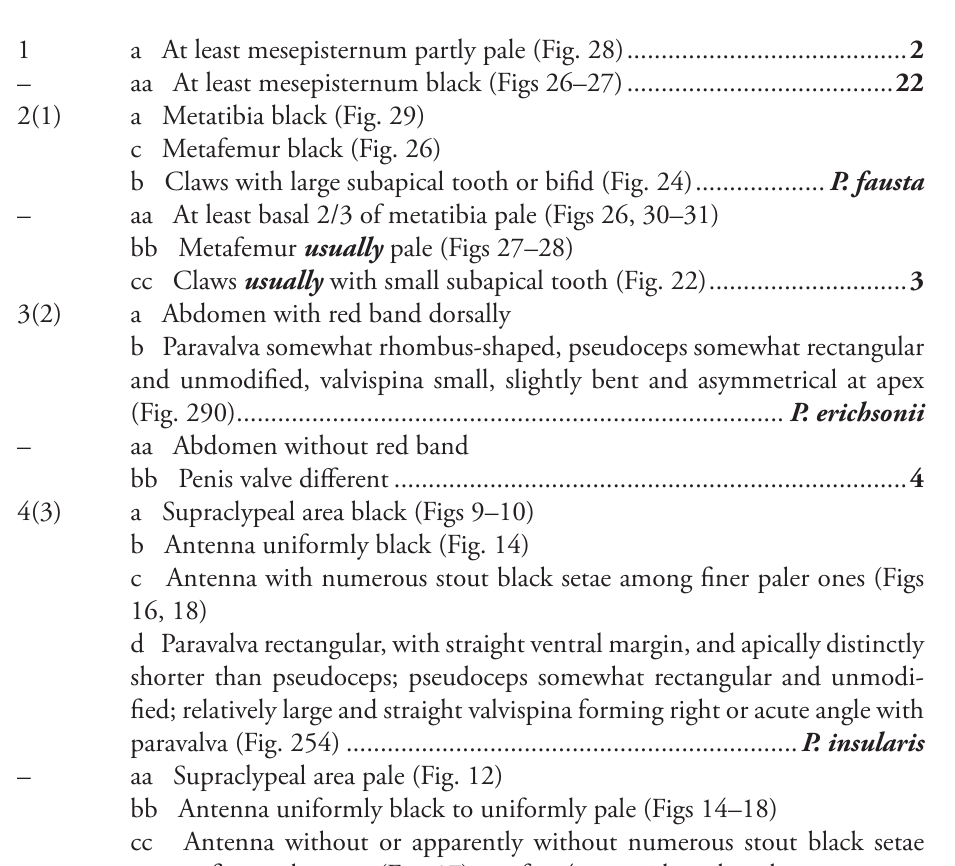
b Antenna uniformly black (Fig.